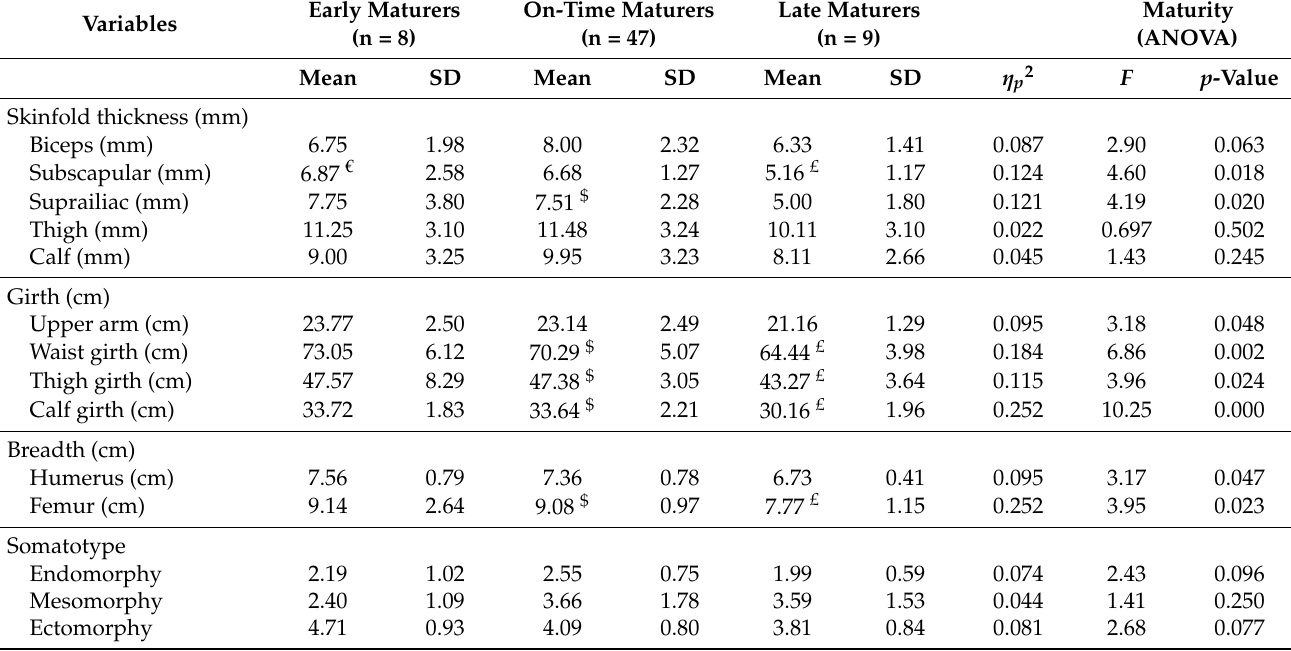
Table 2. Longitudinal and transversal dimensions by maturity status.